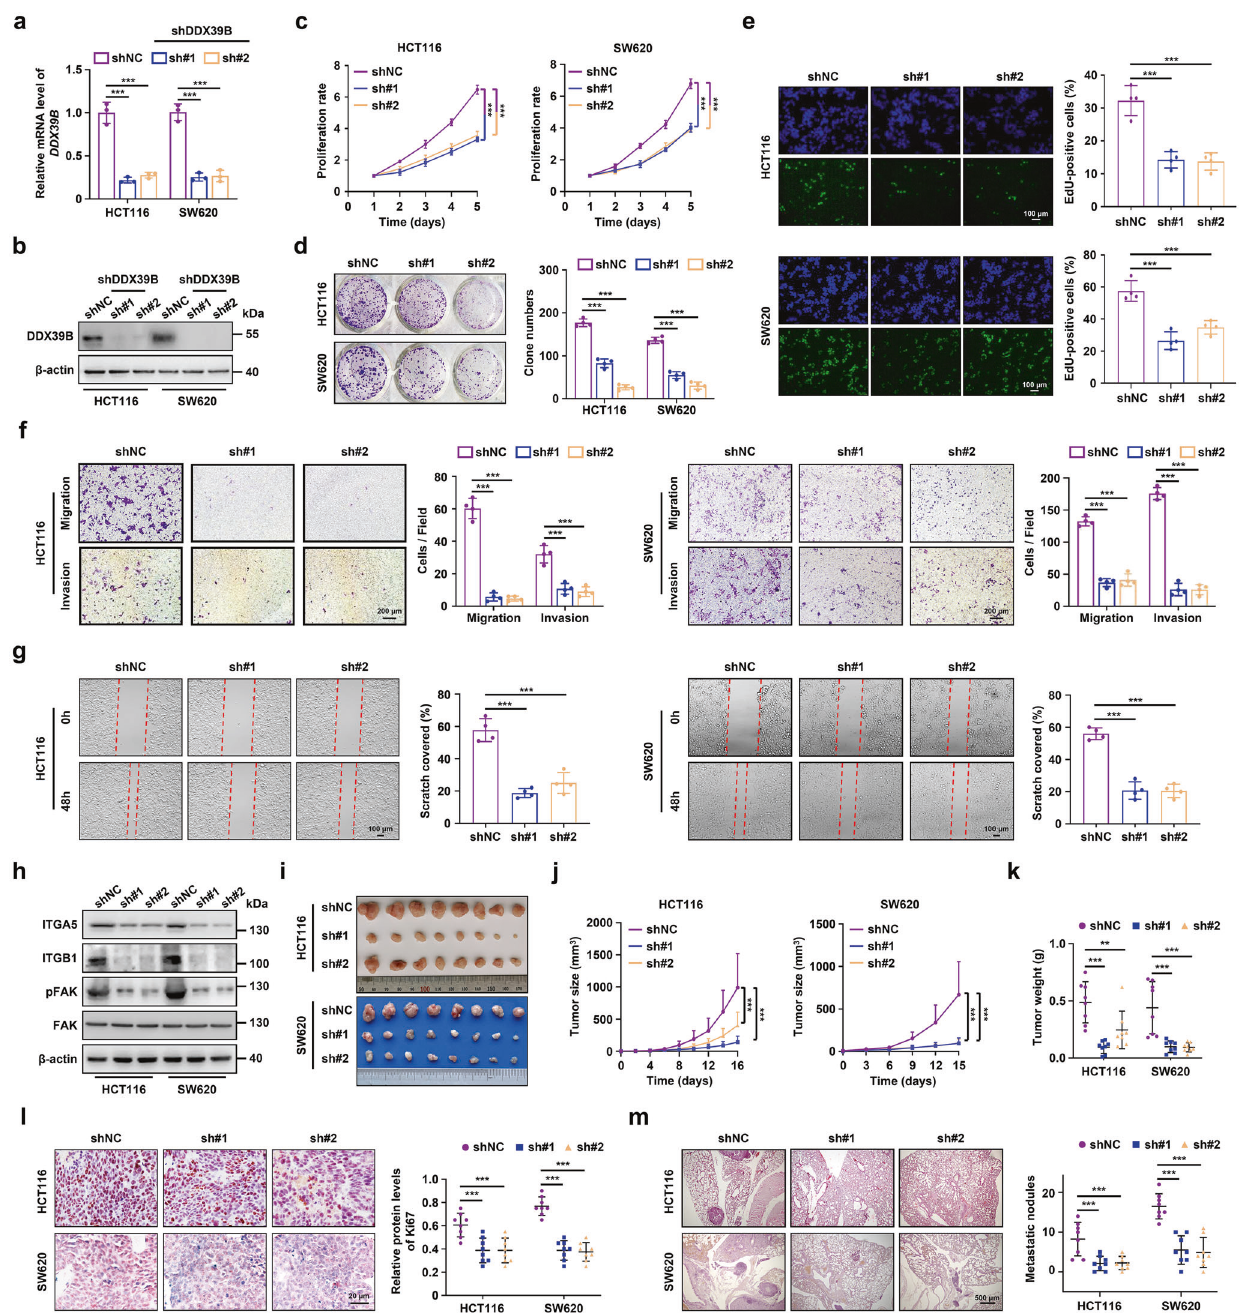
Fig. 3 DDX39B knockdown inhibits CRC growth and metastasis in vitro and in vivo. Knockdown ef fi ciency mediated by two lentivirus- delivered DDX39B-speci fi c shRNA (sh#1 and sh#2) was veri fi ed by qRT-PCR ( a ) and western blotting ( b ) in HCT116 and SW620 cells. The cell viability and proliferation of DDX39B-knockdown CRC cells were measured by CCK8 assays ( c ), colony formation assays ( d ), and EdU assays ( e ). The motility of DDX39B-knockdown CRC cells was examined by transwell migration/invasion assays ( f ) and wound healing assays ( g ). h The protein levels of ITGA5, ITGB1, pFAK Y397 , and FAK in DDX39B-knockdown CRC cells were detected by western blotting. The growth and metastatic abilities of DDX39B-knockdown CRC cells in vivo were assessed in nude mice by subcutaneous and lung metastasis tumor models ( n = 8), respectively. The images ( i ), tumor sizes ( j ), tumor weights ( k ), and Ki-67 expression ( l ) of subcutaneous xenografts are presented. Representative pulmonary metastases detected by H&E staining are shown, along with the number of metastatic nodules ( m ). Data are presented as mean ± SD. The p values were obtained by two-way ANOVA ( c, j ) or one-way ANOVA (others). ** p < 0.01, *** p < 0.001